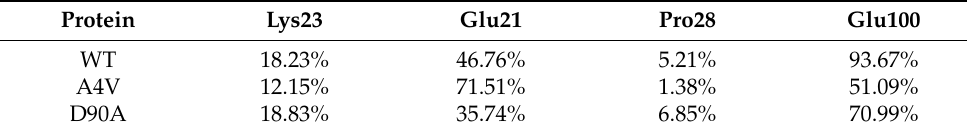
Table 3. Hydrogen bond occupancy of the SBL-1-SOD1 complex.